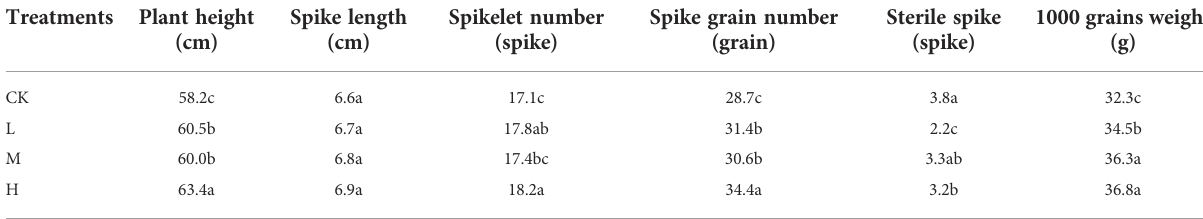
TABLE 3 Differences in plant height, spike length, spikelet number, spike grain number, sterile spike and 1000 grains weight of wheat under different treatments in 2019. Treatments